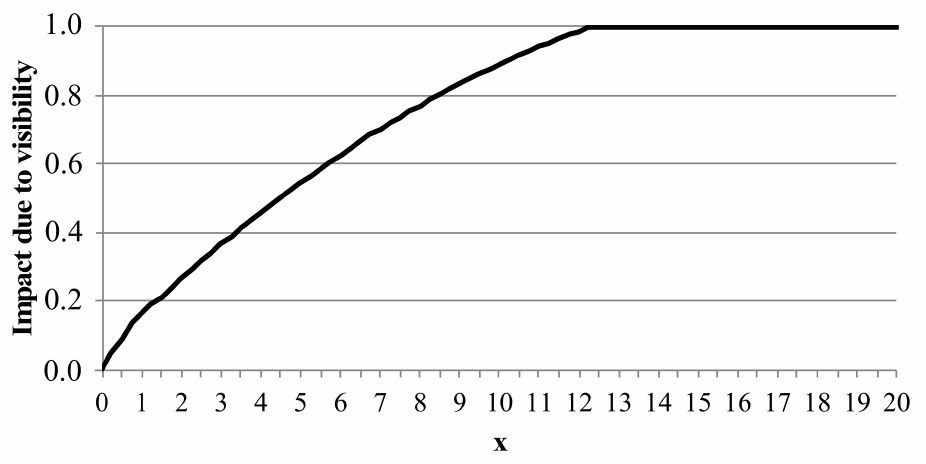
Figure 3. The value function I vis , adopted from